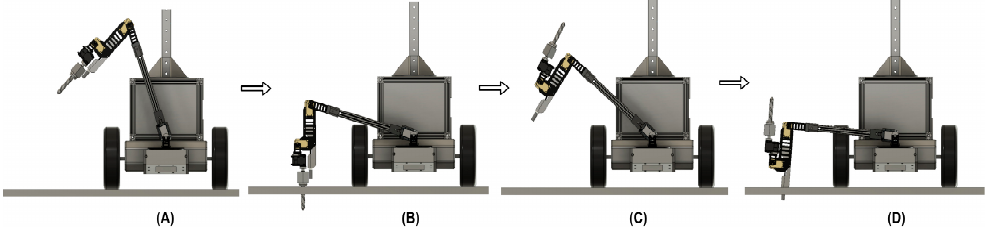
Figure 11. Soil sensing procedures: ( A , B ) Drill deploying and drilling into Soil, ( C , D ) soil sensor entering the soil to take temperature and humidity